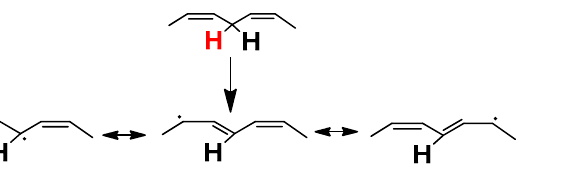
Figure 2. Rearrangement of the 1,4-pentadiene structure to give a stabilized conjugated